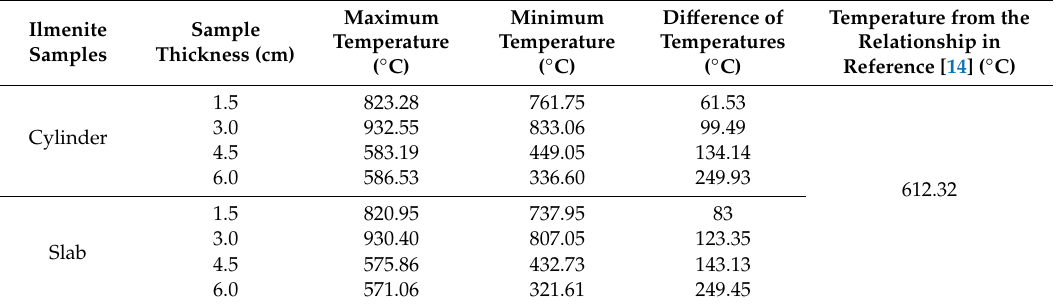
Table 4. Maximum and minimum temperatures attained in the ilmenite samples with cylinder and slab shapes after heating for 4 min using the 5.55-kW microwave batch furnace. Ilmenite Sample Samples Thickness